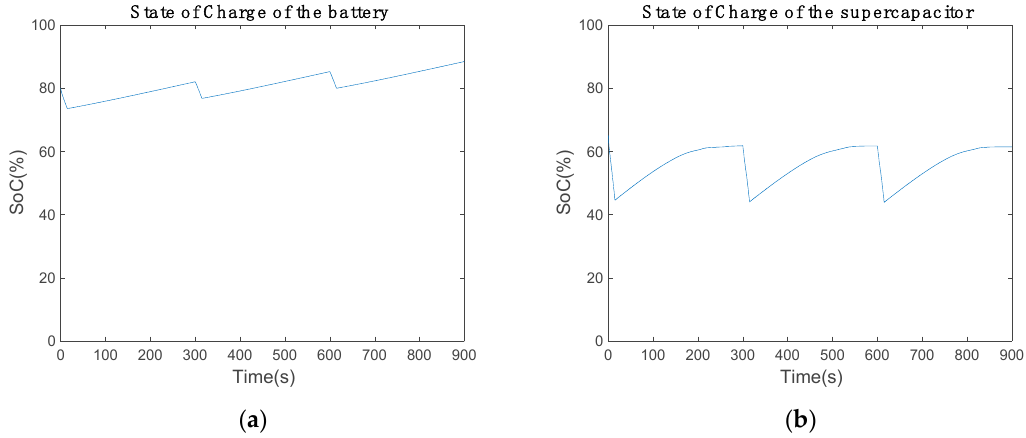
Figure 10. State of charge of the power supply over 900 s using a ( a ) battery and ( b ) 2.5 F supercapacitor.